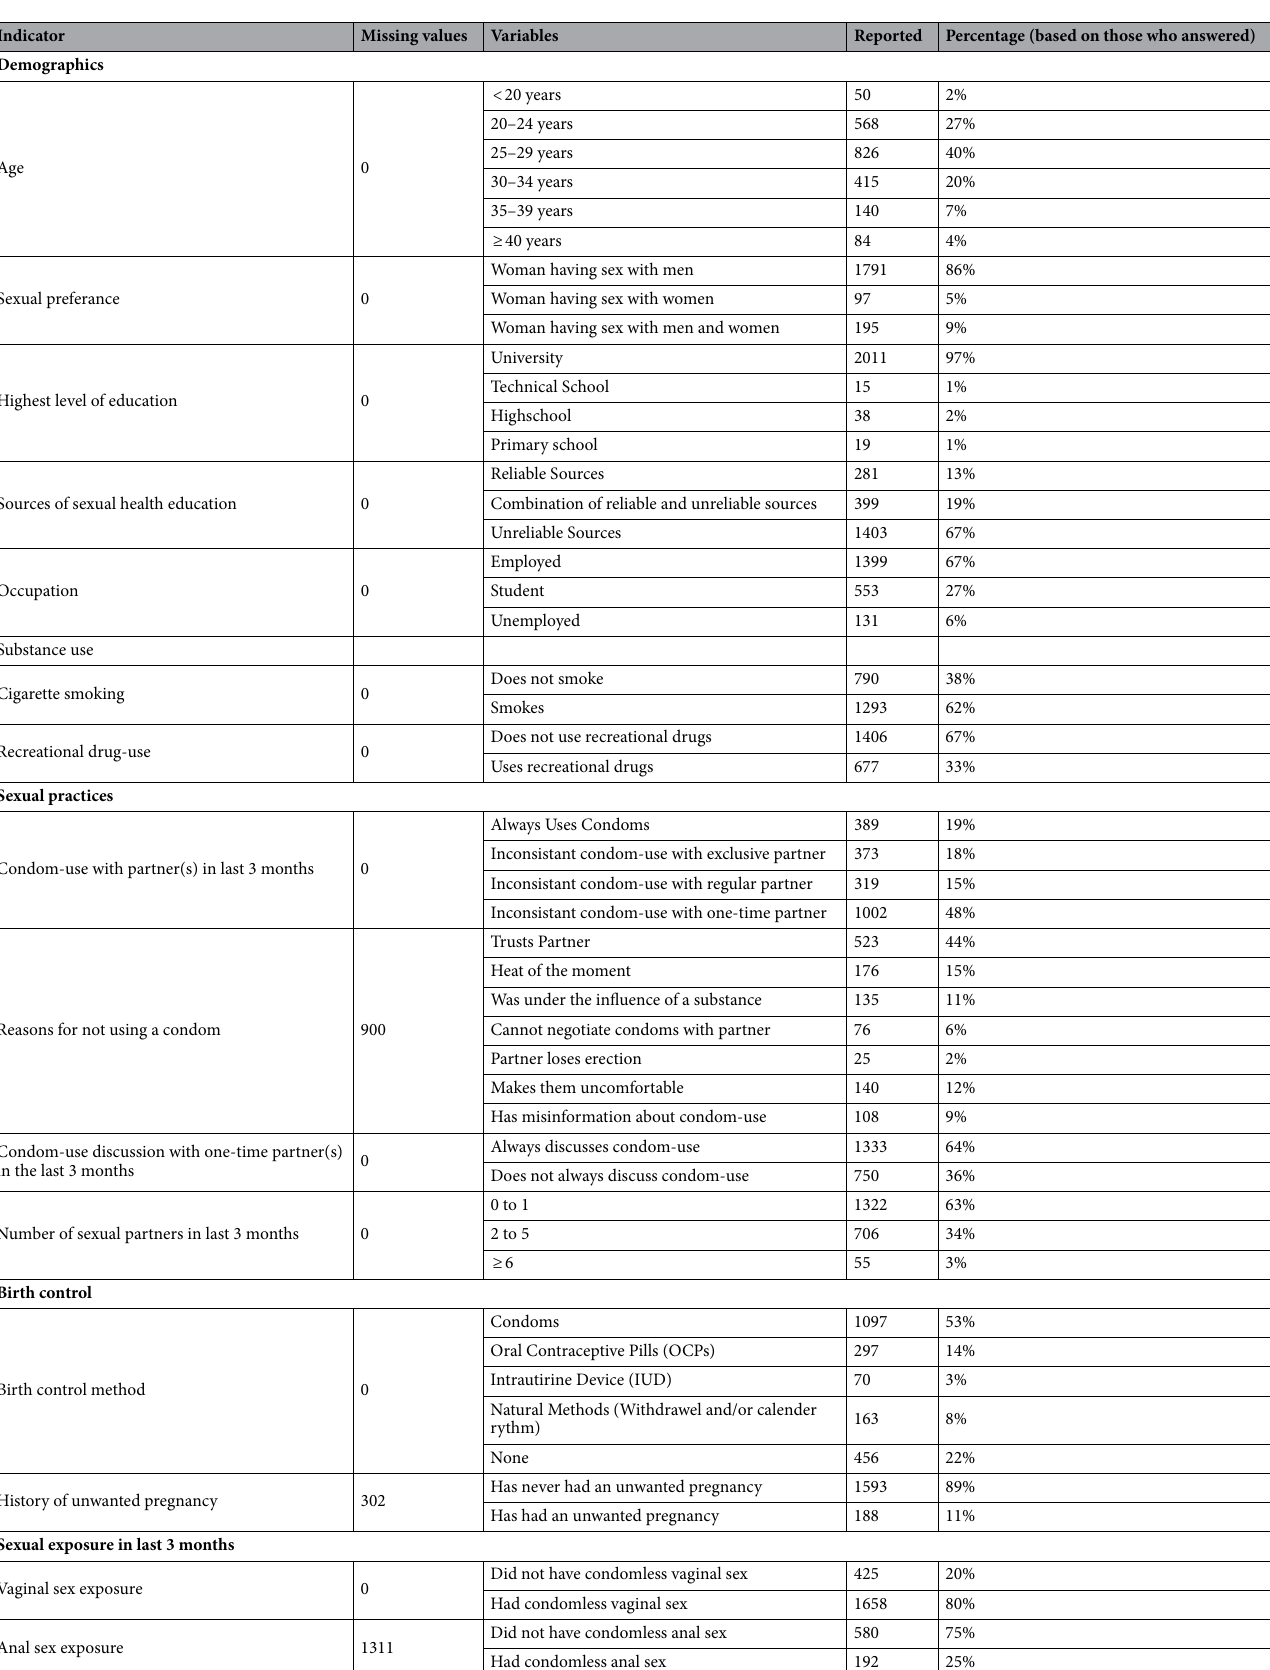
Table 1. Demographics, substance use, sexual practices and sexual exposures in 2083 women in